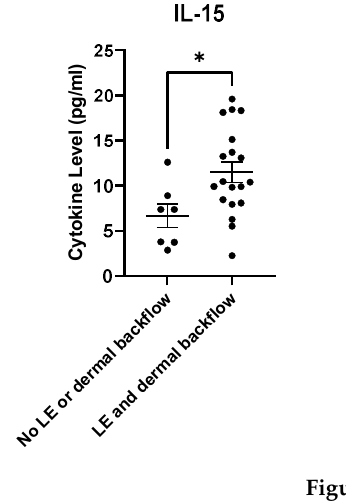
pared to subjects with no clinical BCRL or dermal backflow. * p ≤ 0.05, ** p ≤ 0.01, *** p ≤ 0.001. 3.6. Several 12-Months Post-RT Cytokines/Chemokines Were Elevated in Subjects with Both